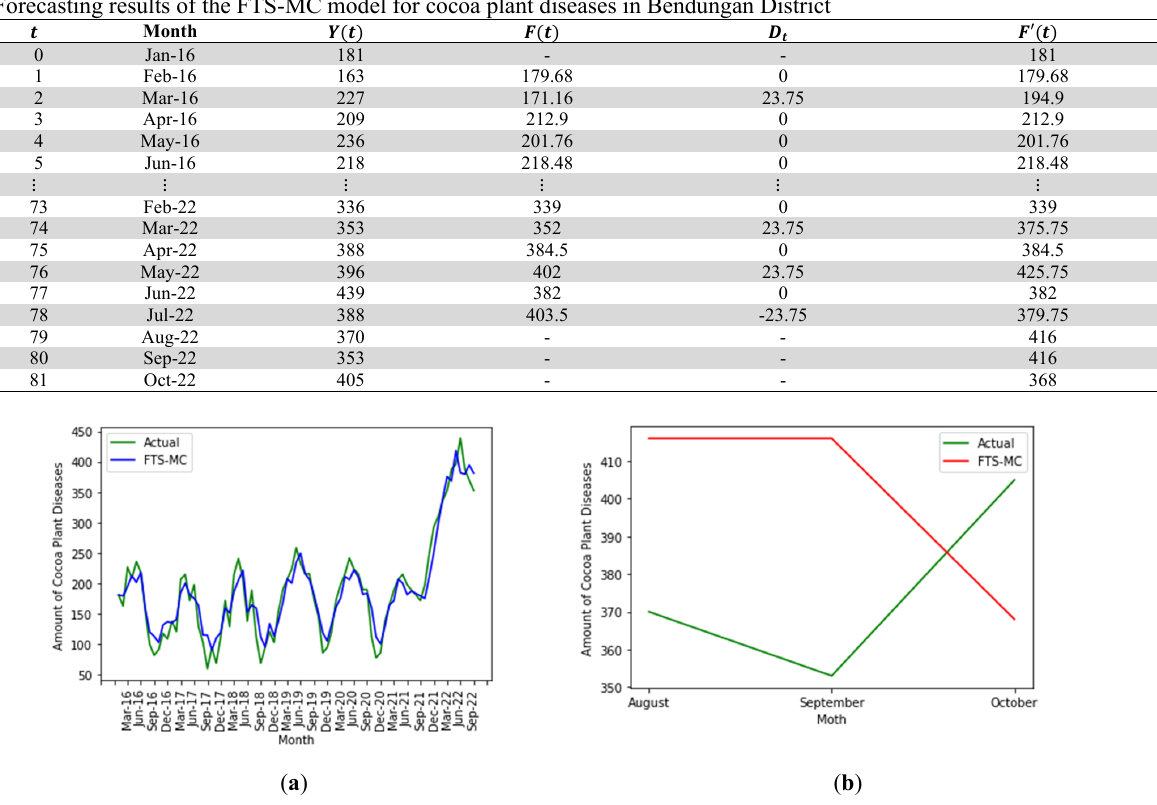
Fig. 2. Graph of comparison of actual data with forecasting results of the FTS-MC Model for forecasting the number of diseases cocoa plant in Bendungan District. (a) data from January 2016-October 2022; (b) data from August-October